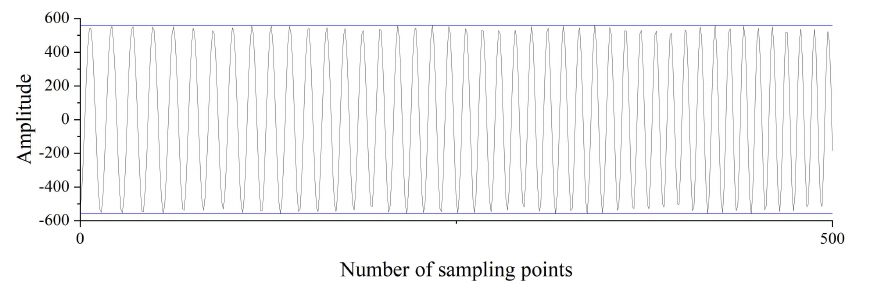
Figure 12. Frequency − varying signal after a dynamic filter.